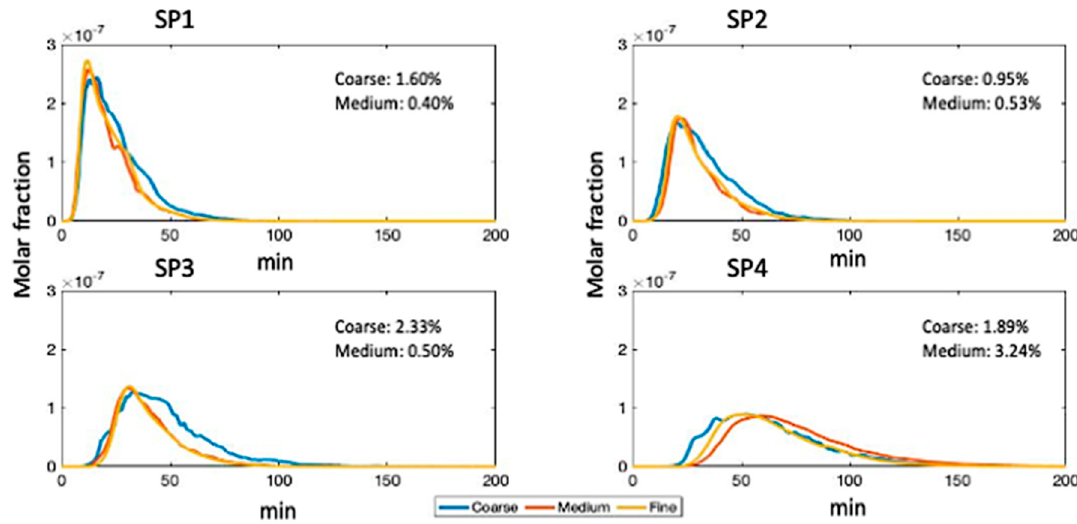
Figure 2. Mesh independence simulations (sampling ports, SP).